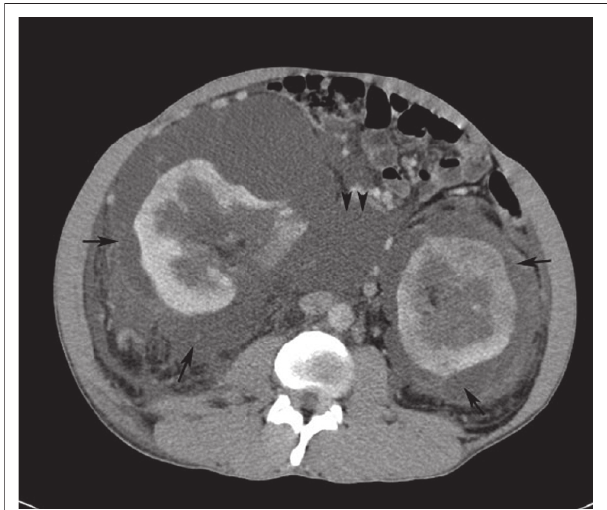
FIGURE 3: Axial contrast-enhanced CT scan. Bilateral low density perinephric collections (black arrows) with normal enhancement of the renal parenchyma and communication of collections with each other across the midline